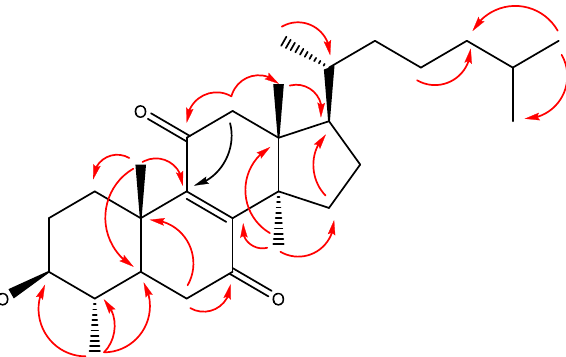
Figure 2. Key HMBC (H → C) correlations of compound 1 .